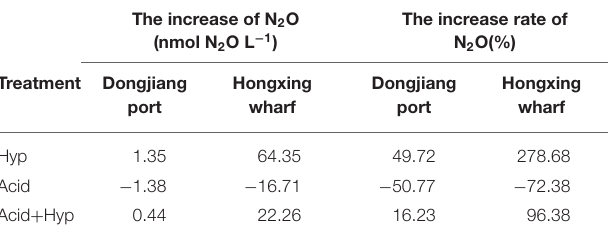
TABLE 3 | Increase in, and the increased rate of, N 2 O under different treatments at the Dongjiang port and the Hongxing wharf. The increase of N 2 O (nmol N 2 O L − 1